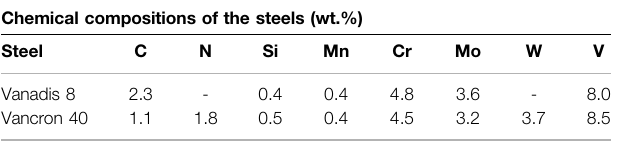
TABLE 2 | Chemical composition (wt%) and heat treatments of the martensitic tool steels. Chemical compositions of the steels